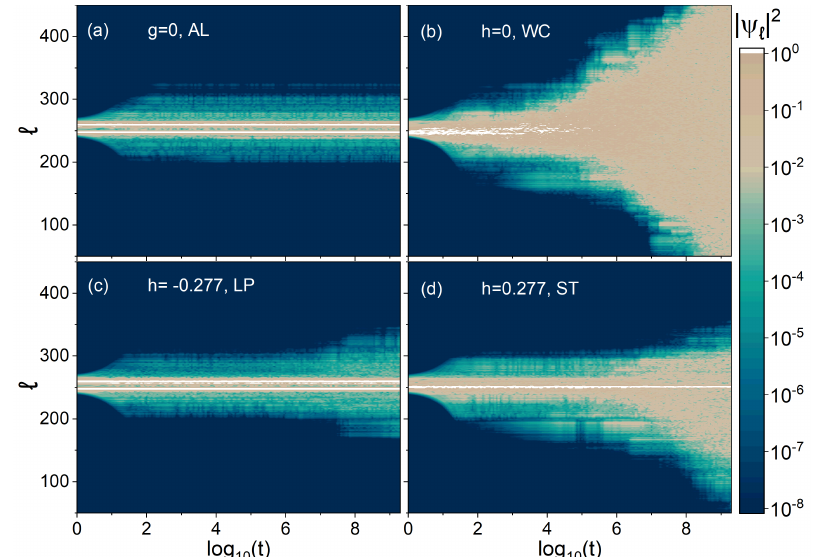
Figure 2: Different regimes of density resolved wave packet spreading. The evolution t . (a) Anderson localization (AL): of the norm density | ψ (cid:96) | 2 is plotted versus log 10 g = 0, h = − 0.277. (b) Weak chaos (WC): g = 1, h = 0. (c) Lifshits phase (LP): g = 1, h = − 0.277. (d) Self-trapping (ST): g = 1, h = 0.277 (here ∆ t = 0.05). For all cases a = 0.1, W = 4, and one and the same disorder realization are used here for all